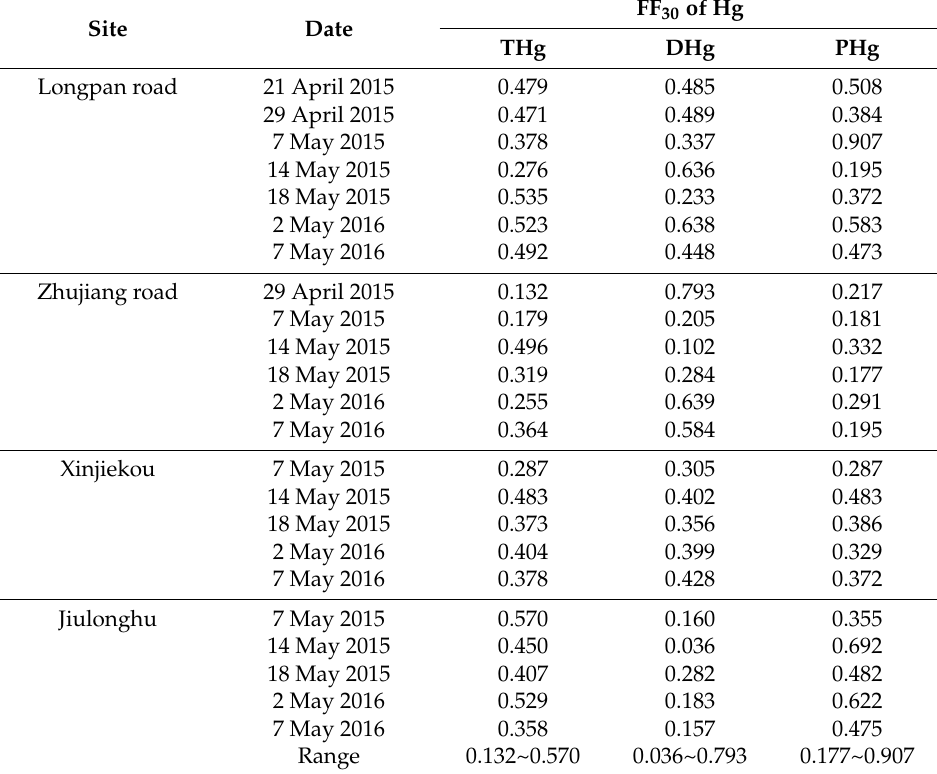
Table 7. First Flush effect (FF 30 ) of THg, DHg and PHg in different rainfall